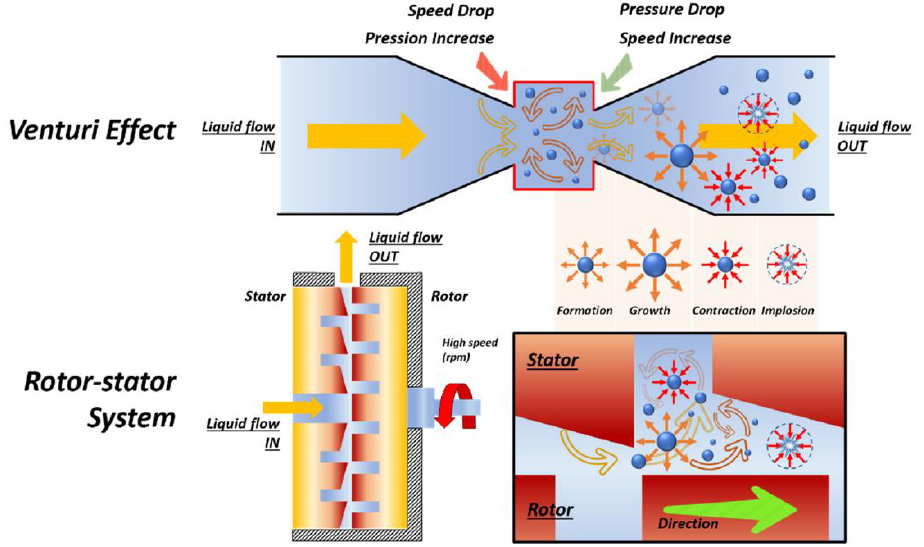
Figure 4. Hydrodynamic cavitation phenomenon in a fluid: Venturi effect and rotor-stator system [47]. Table 1. Pilot and semi-industrial scale US extraction studies, from 2017 to